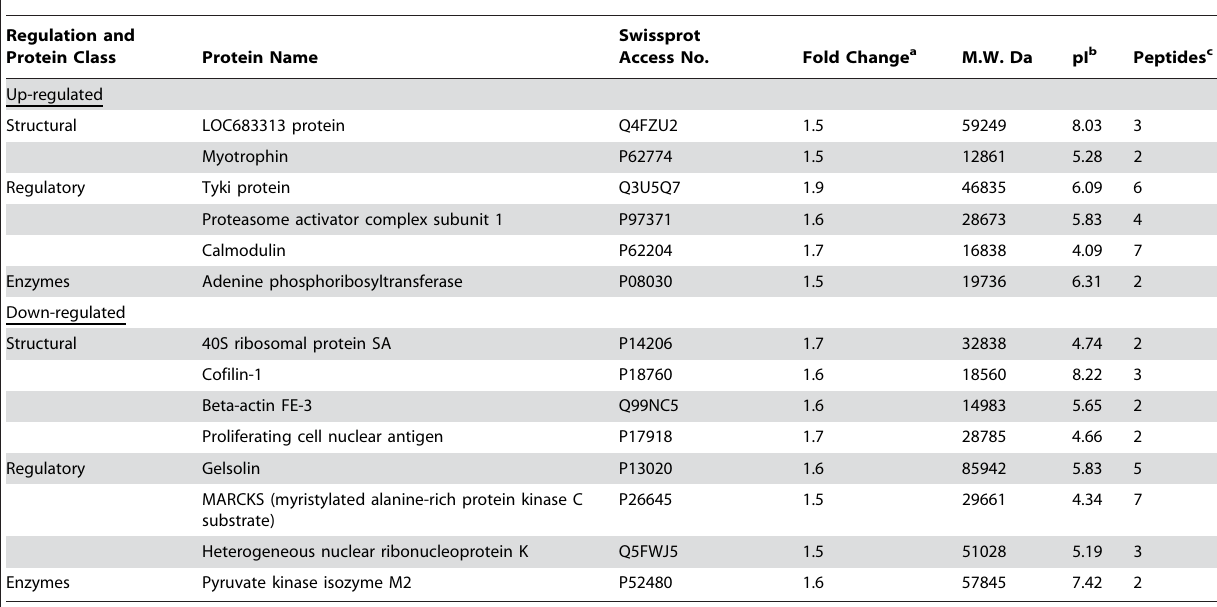
Table 1. Changes in the proteome of HIV-1/VSV infected microglia.